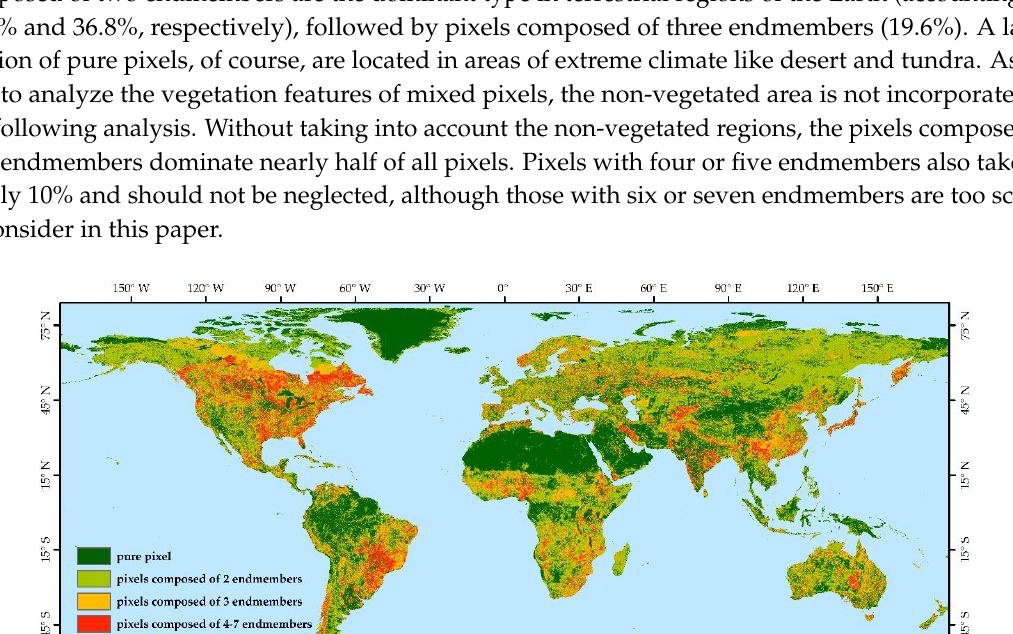
Figure 4. Global distribution of the number of endmembers at a 1-km resolution.